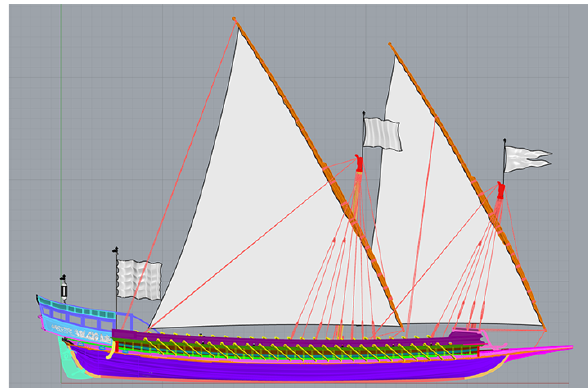
Figure 7. The Artu Chiggiato’s drawing